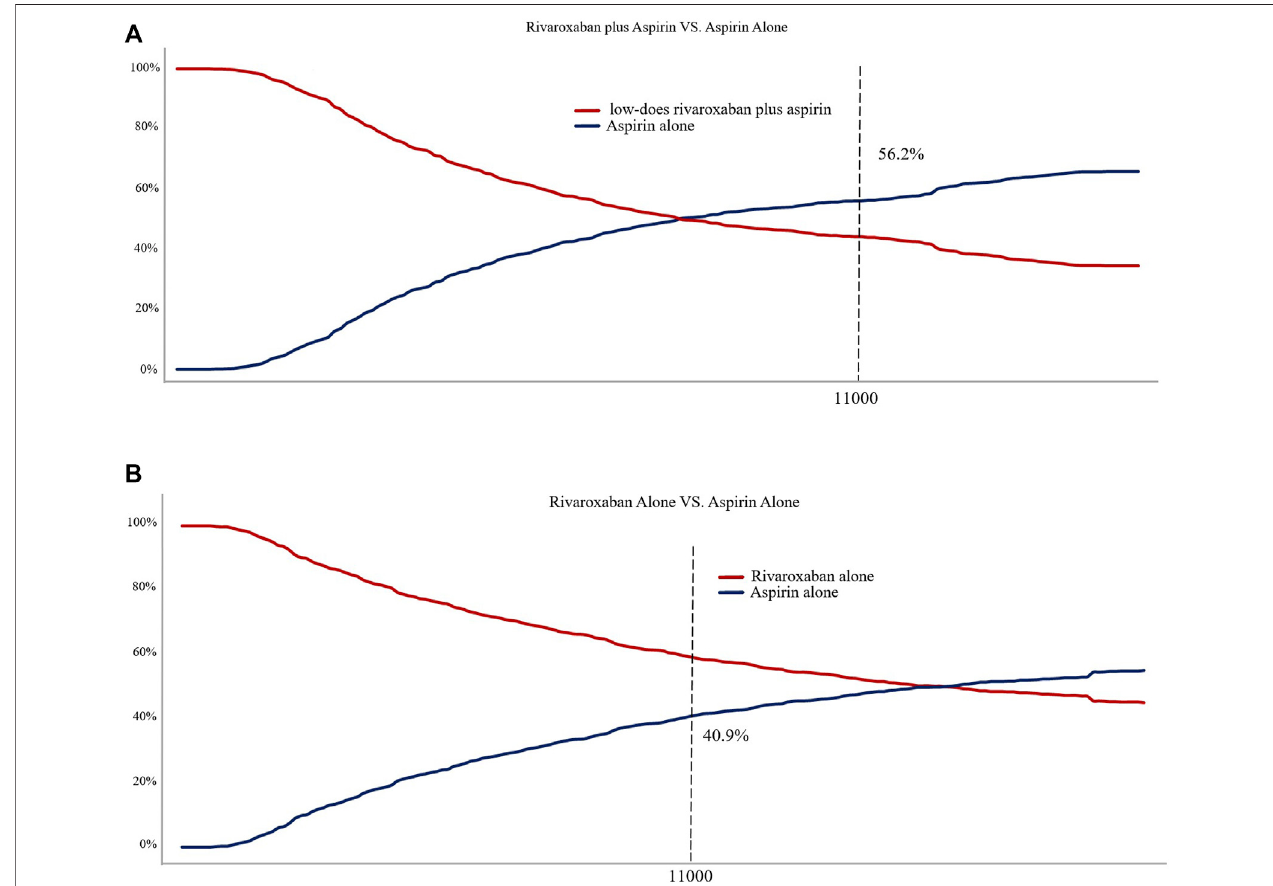
FIGURE 4 | (A) Cost-effectiveness acceptability curve showing the maximum willingness to pay and the corresponding probability of cost-effectiveness for Low- does rivaroxaban plus aspirin group vs. Aspirin alone group. (B) Cost-effectiveness acceptability curve showing the maximum willingness to pay and the corresponding probability of cost-effectiveness for Rivaroxaban alone group vs. Aspirin alone